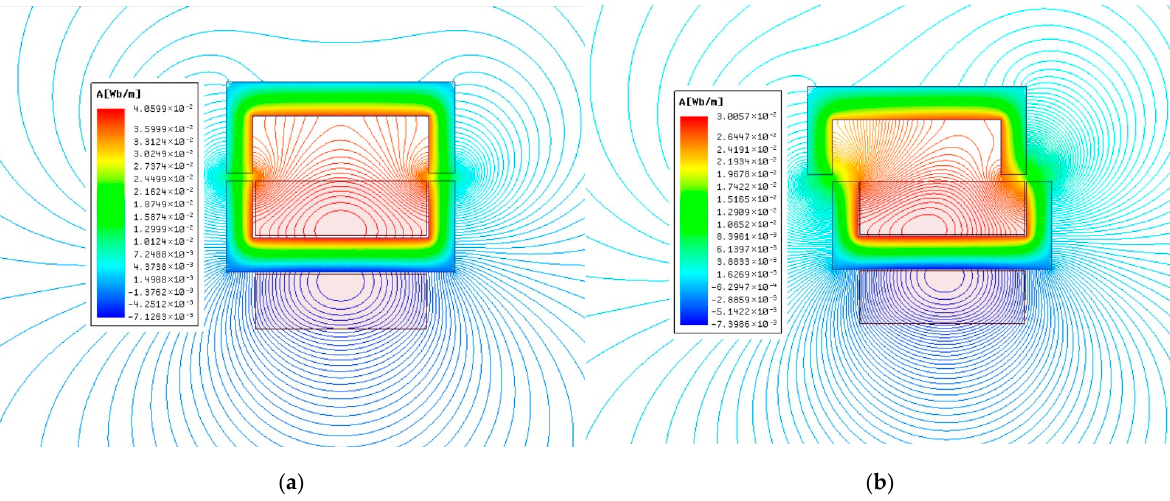
Figure 4. Two-dimensional simulation results with horizontal misalignment (distribution of magnetic induction line). ( a ) ∆𝑦(𝑡) = 0 ; ( b ) ∆𝑦(𝑡) = 2𝑎 . Table 1. The simulation results of the suspension force amplitude.